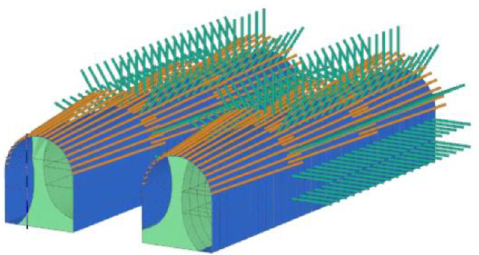
Figure 11. Excavation of the two pilot tunnels and construction of an intermediate wall.